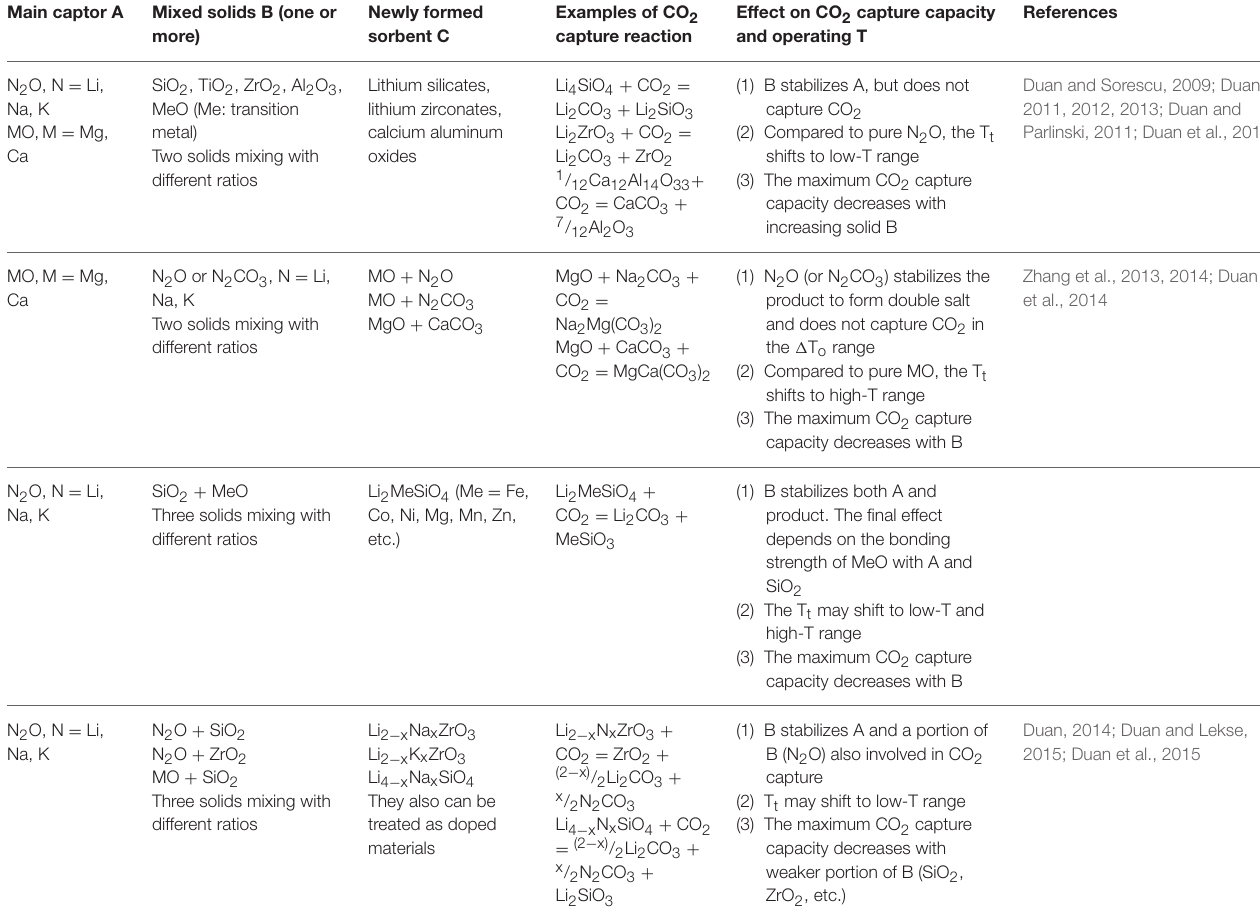
TABLE 1 | Mixing schemes and examples of mixed solids and their effects on CO 2